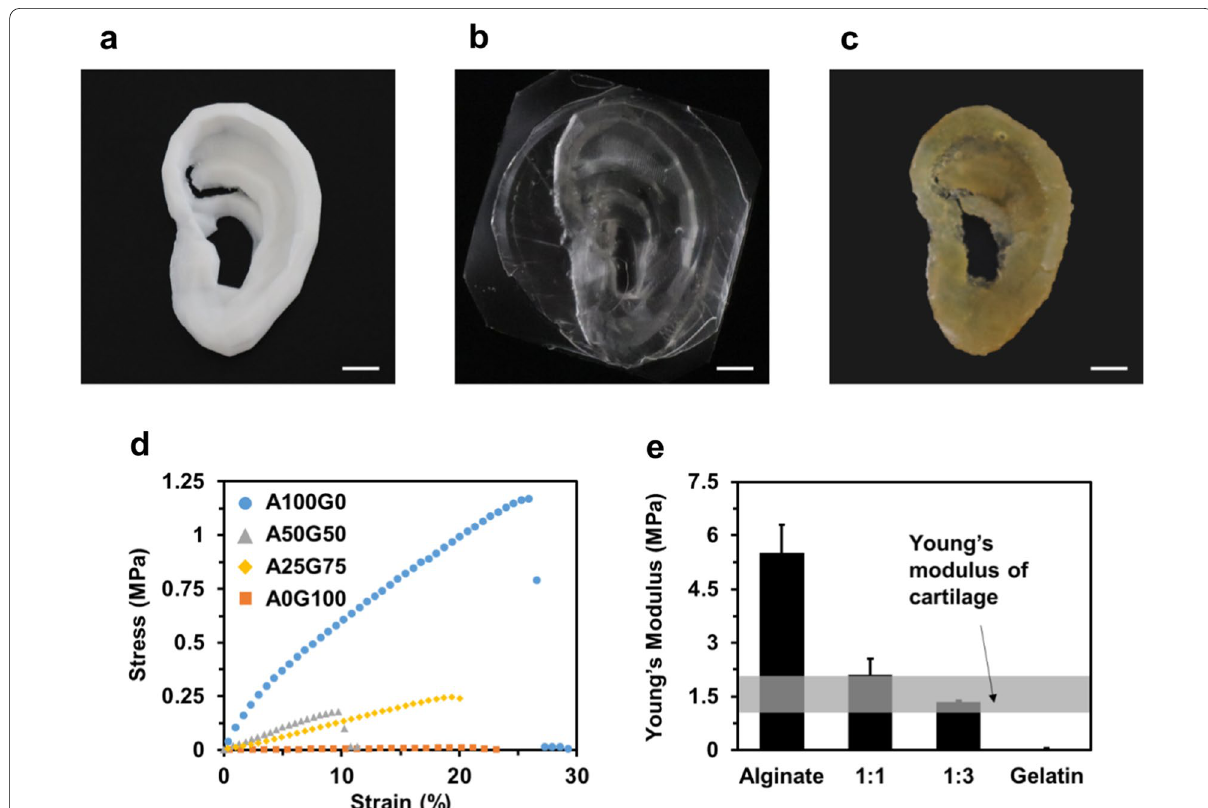
Fig. 2 a The 3D ear cartilage-shaped template printed by an FDM 3D printer. b The PDMS negative mold for the production of the 3D ear cartilage-shaped hydrogel collector. c 3D ear cartilage-shaped hydrogel collector made of a mixture of alginate and gelatin. d Strain–stress curve of the 4 specimens with the different mixing ratios of alginate and gelatin. e Young’s modulus of the 4 specimens and the range of Young’s modulus of native ear cartilage (gray region). All scale bars are 1